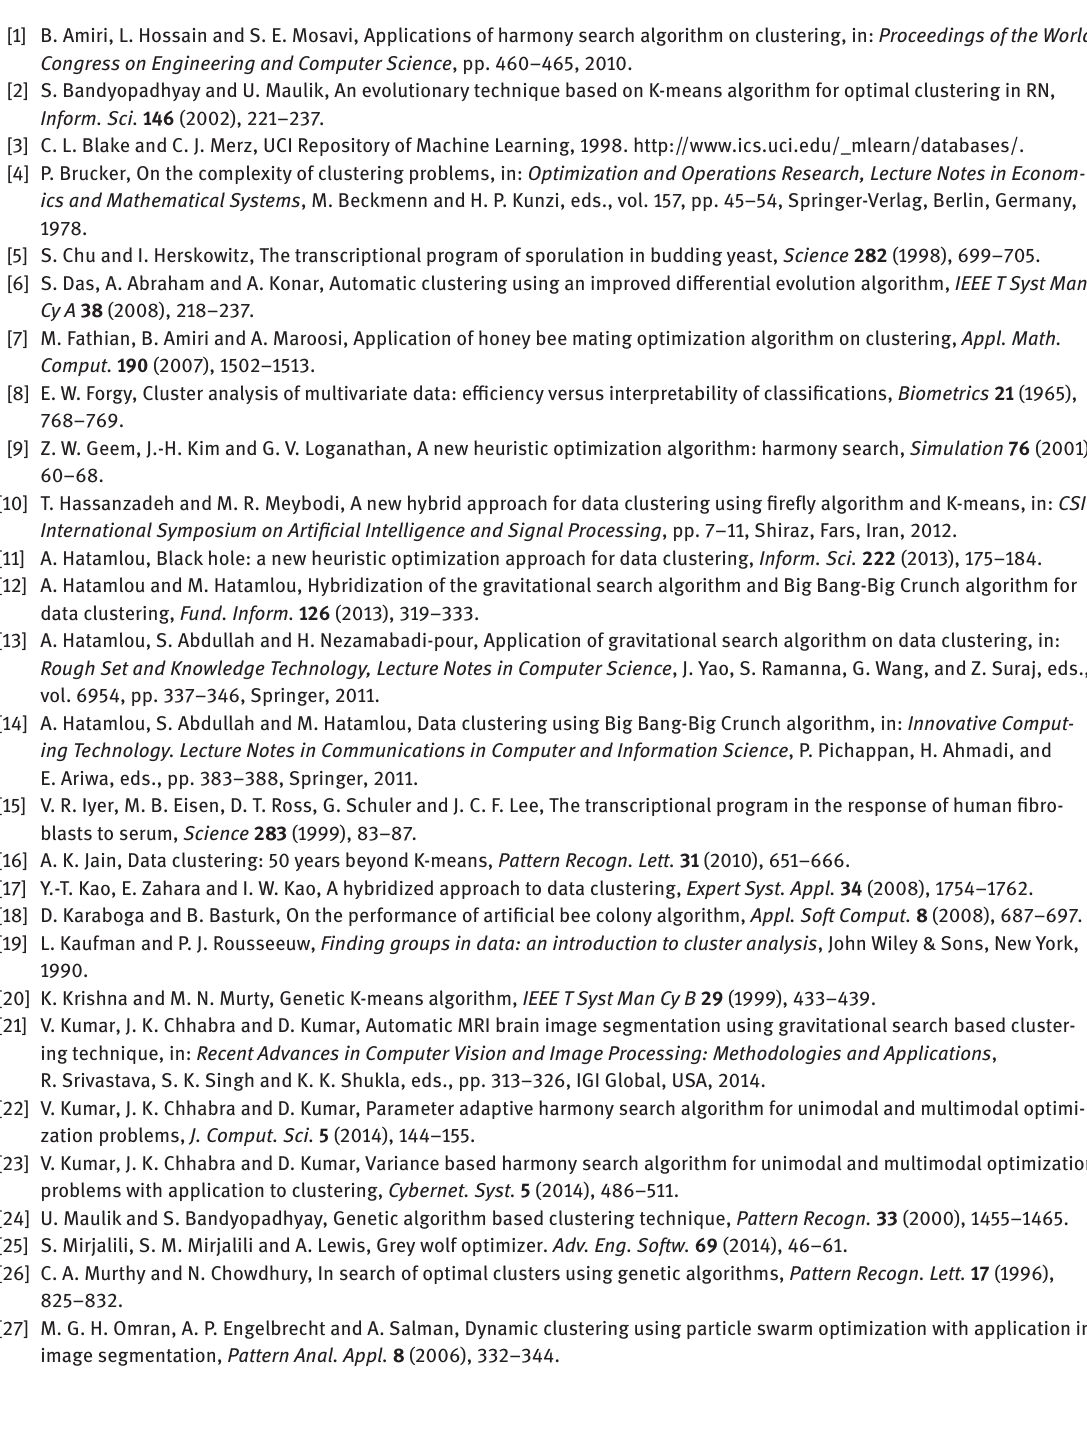
eight data sets. The experimental results revealed that GWAC outperformed the other algorithms in most of the data sets. Statistical analysis also demonstrated that the proposed GWAC is statistically significant. The GWAC has further been applied on gene expression data. Comparing the results of the GWAC with the other well-known techniques, the GWAC outperforms the recently developed